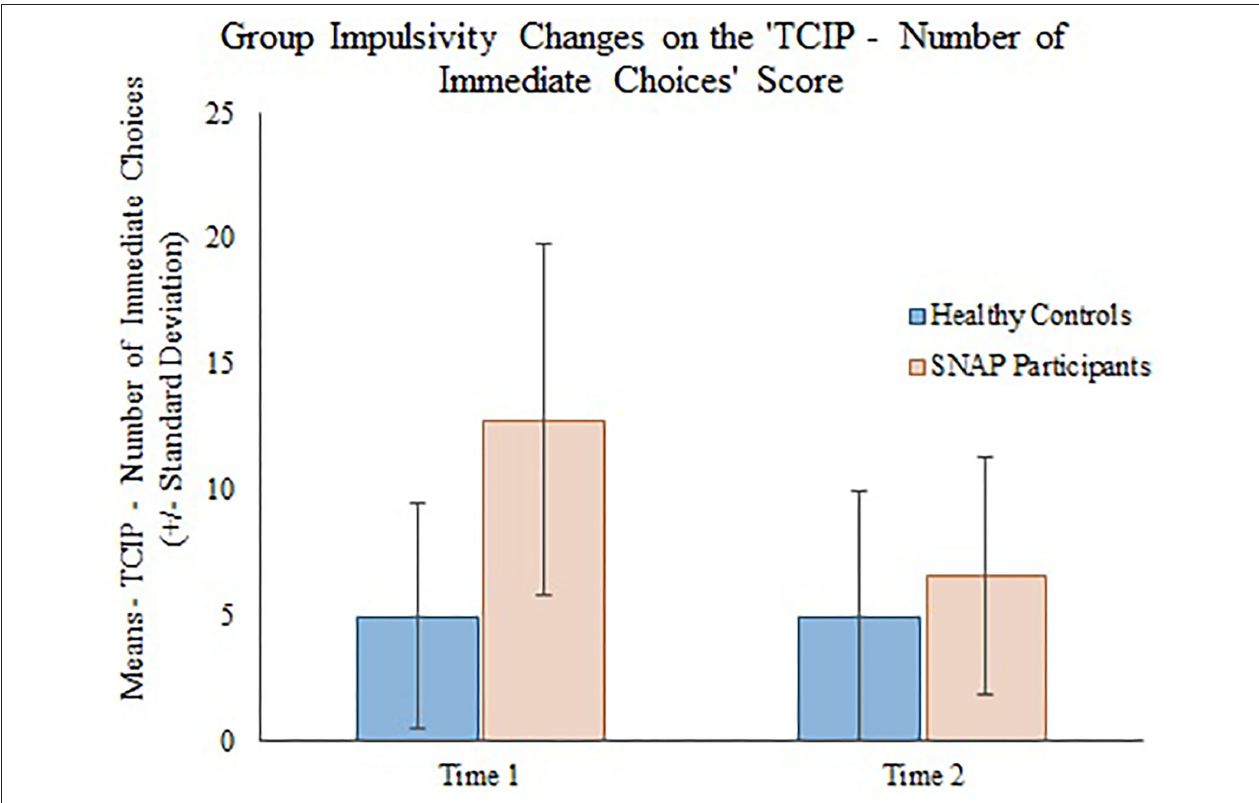
FIGURE 1 | Group impulsivity changes on the Two Choice Impulsivity Paradigm–Number of Immediate Choices score.